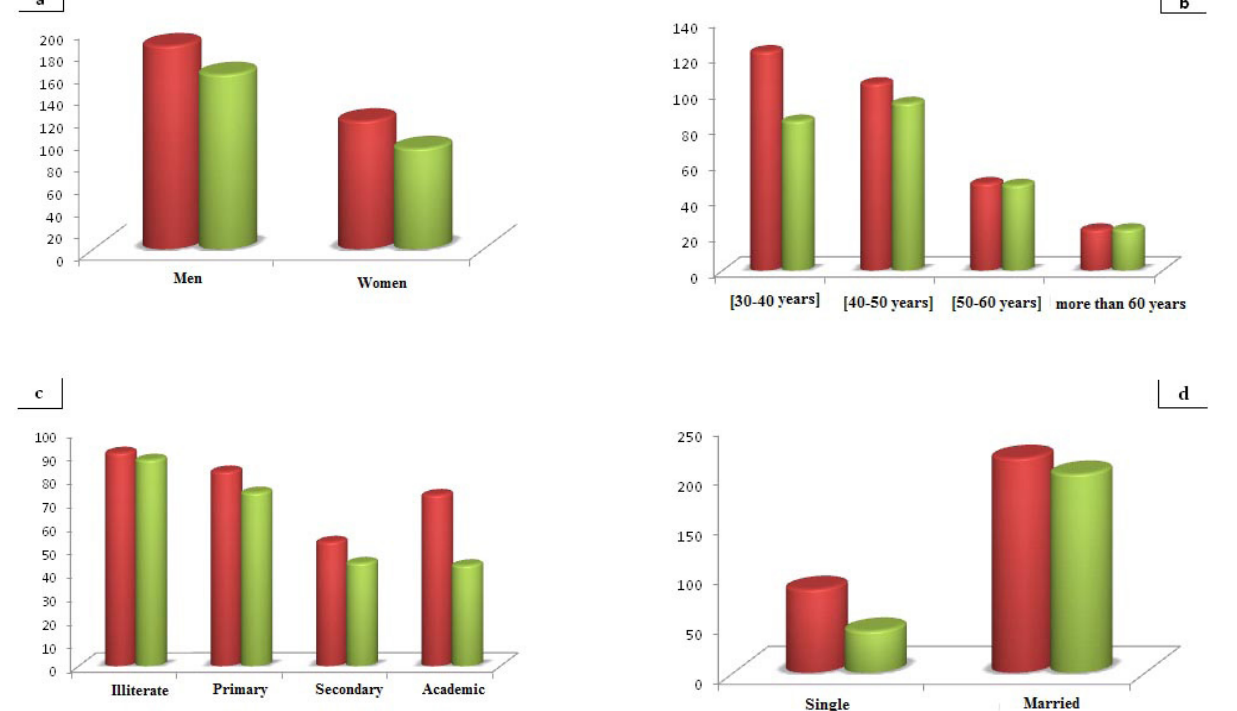
Figure 3. Distribution of Chamaerops humilis use according to the sex (a), age (b), the intellectual level (c) and marital status (d). Red bars indicate n. of people investigated and green bars indicate n. of people using